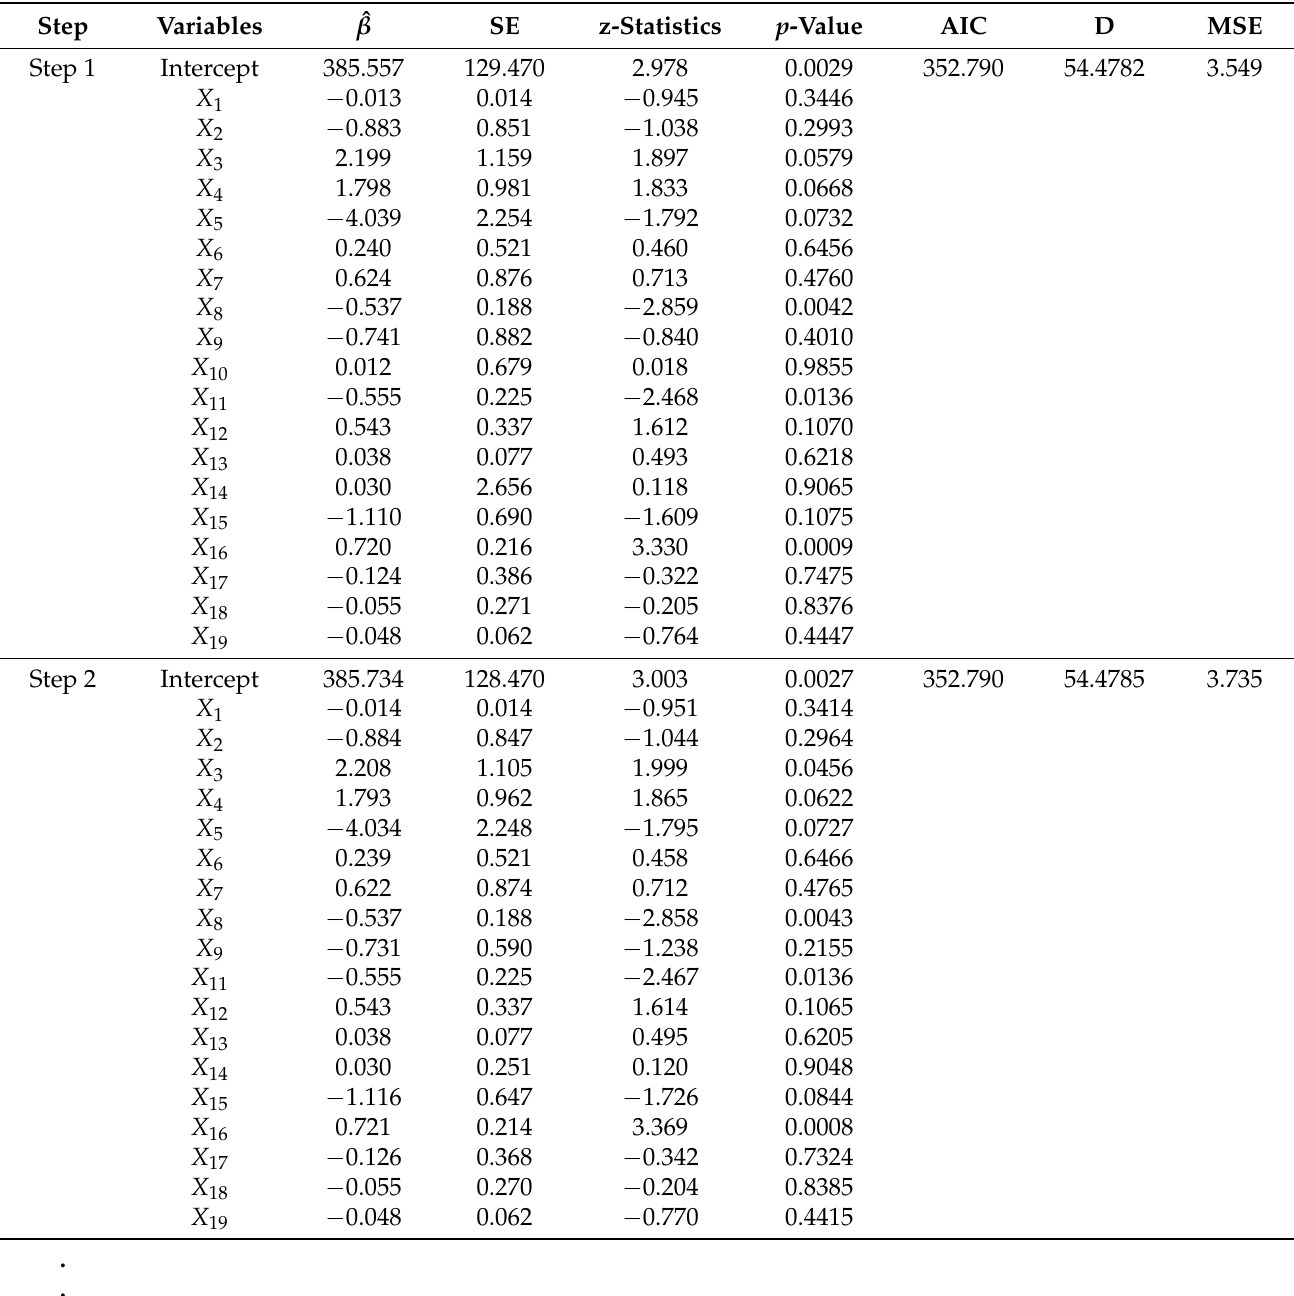
Table 4. The Model I (backward selection